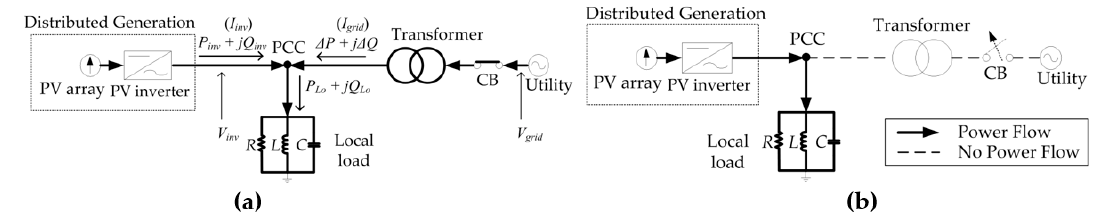
Figure 1. Description of islanding phenomenon: ( a ) grid-connected mode; ( b ) islanding mode.